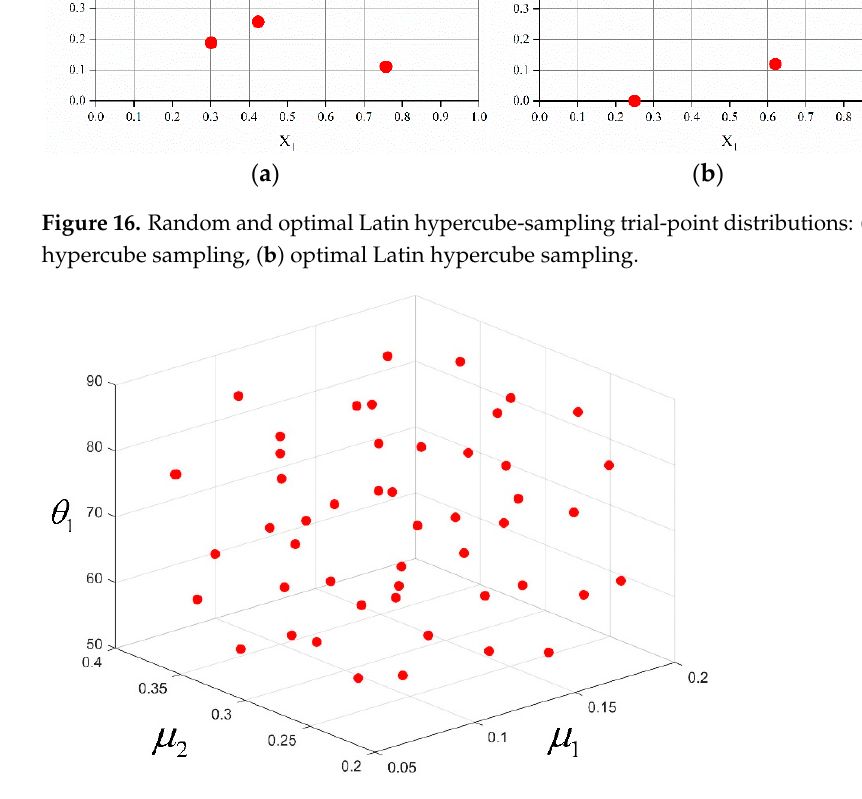
Figure 17. Sample of connection-strength influencing factors.